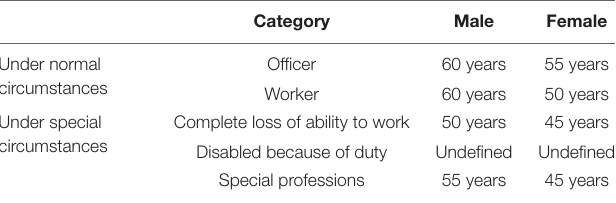
TABLE 1 | Summary of Chinese policies on retirement